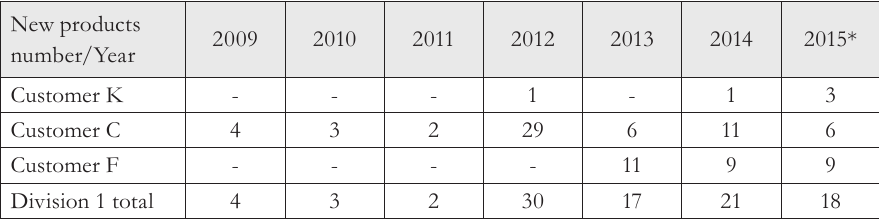
Tab. 2. – The number of new products related to strategic customers in Division 1. Source: